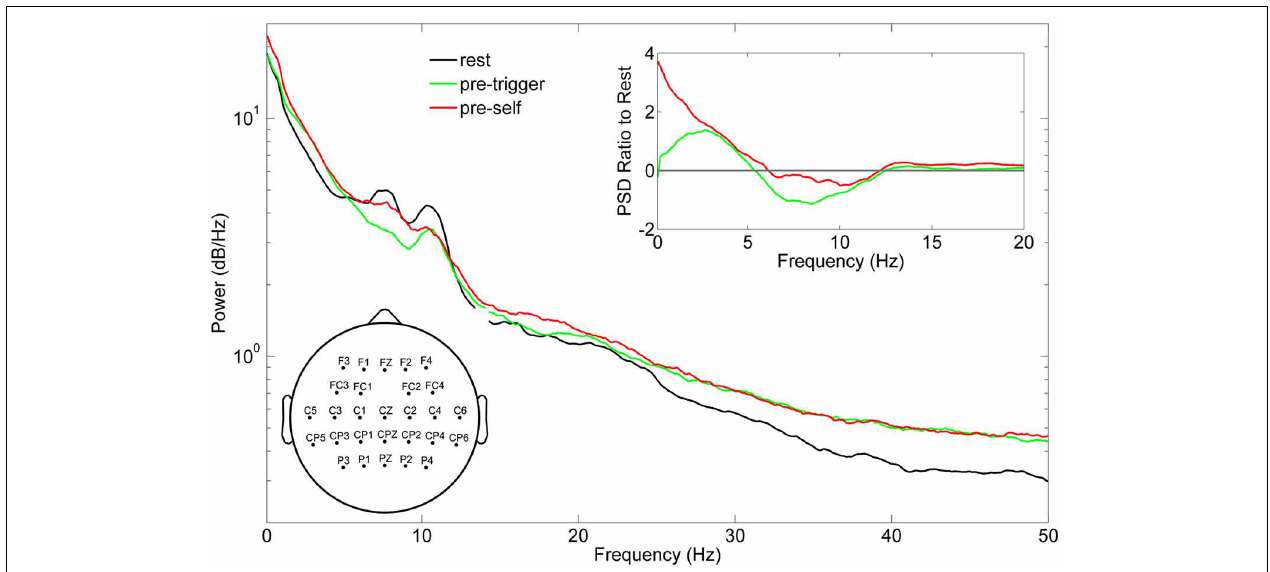
FIGURE 3 | Grand mean power spectral density (PSD) of EEG recordings across the 10 subjects. The PSD was computed across all channels retained for neural decoding (left inset) during quiet standing (black line) and concatenated pre-movement epochs during triggered